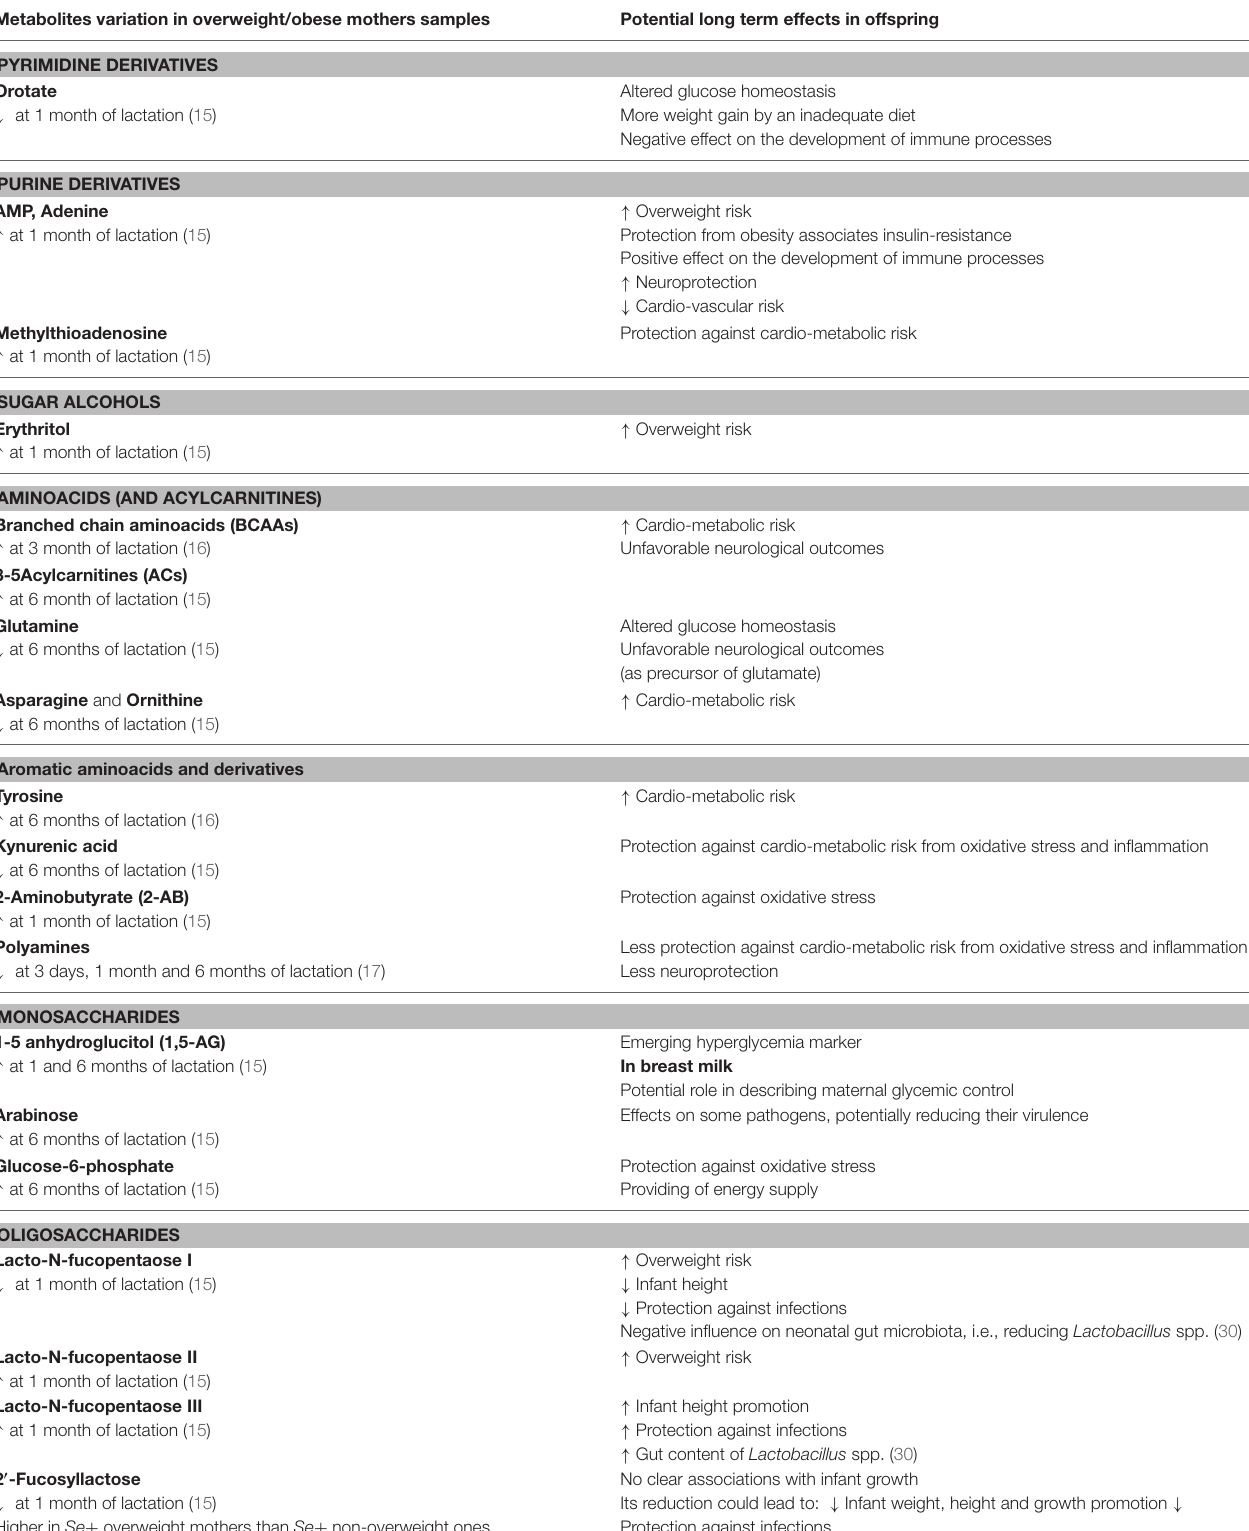
TABLE 1 | Main metabolomics differences detected by comparing breast milk of overweight/obese mothers and lean ones in the different studies, and the potential short- and long-term effects in offspring. Metabolites variation in overweight/obese mothers